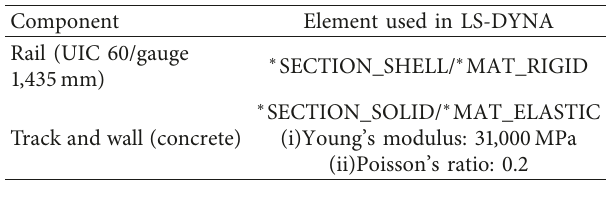
Figure 2: Modeling of the track. Table 1: The element used in LS-DYNA for modeling the track.